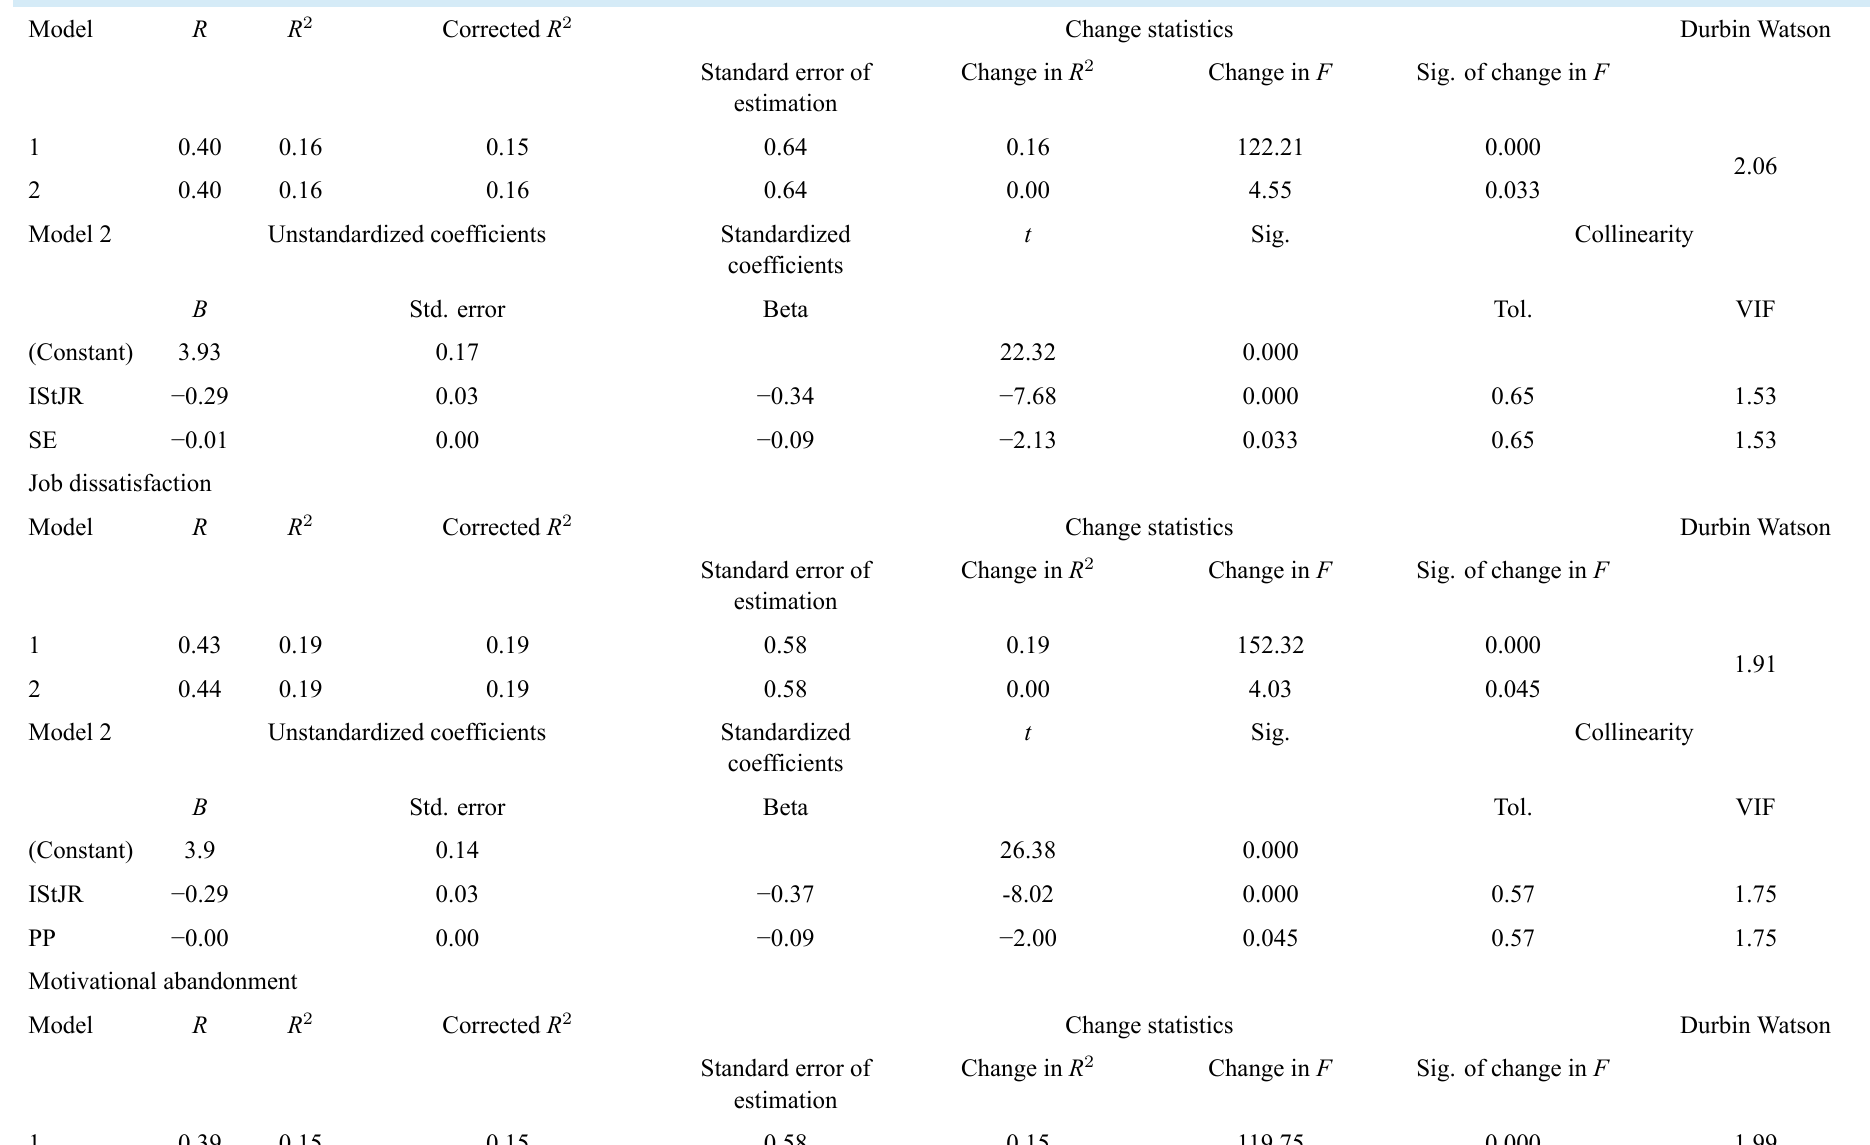
TABLE 3. Stepwise multiple linear regression models for the burnout